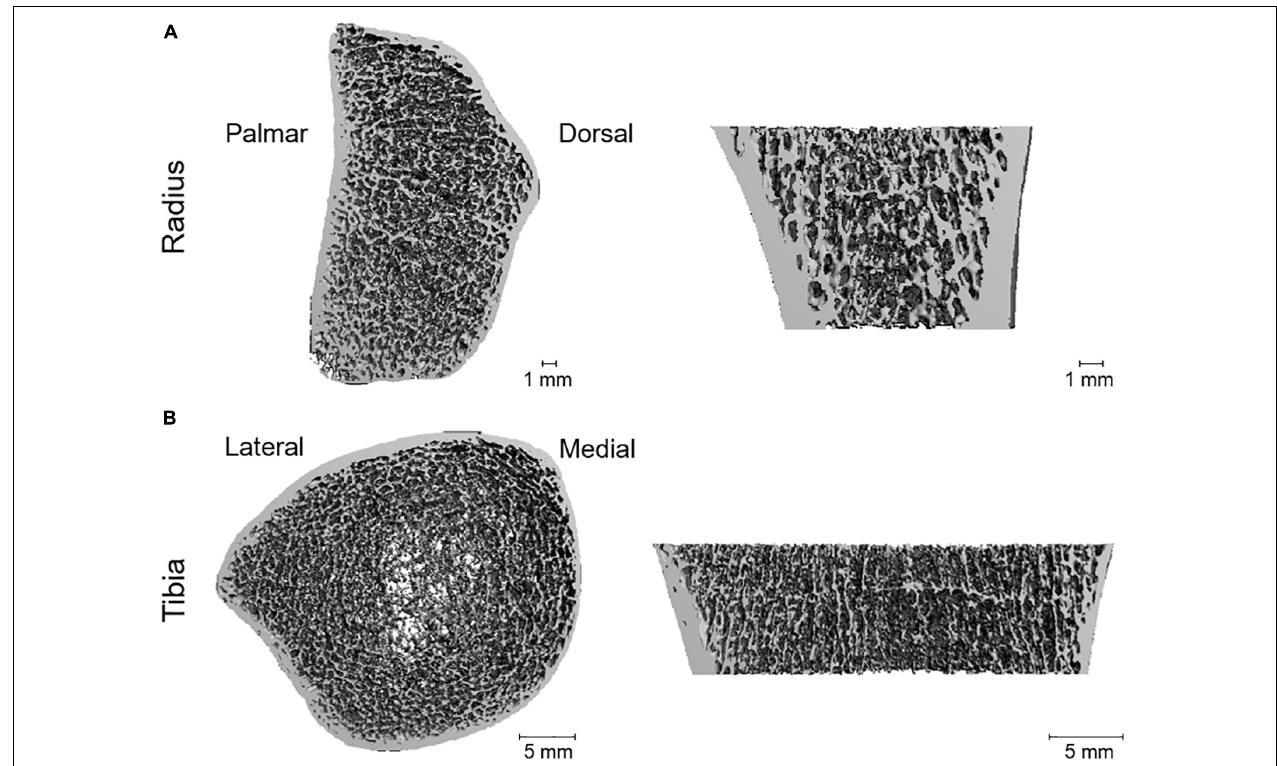
FIGURE 1 | Three-dimensional visualization of the scanned left radius (A) and right tibia (B) of patient 1, obtained with HR-pQCT. (A) Quantification revealed a great resemblance of the radius of the fibrodysplasia ossificans progressiva (FOP) patient to that of an age- and gender-matched reference group, except for cortical density that was higher in the FOP patient. (B) Quantification revealed major dissimilarities with the age- and gender-matched reference group, especially in total and trabecular density (lower in the patient) and in trabecular and cortical microarchitecture.